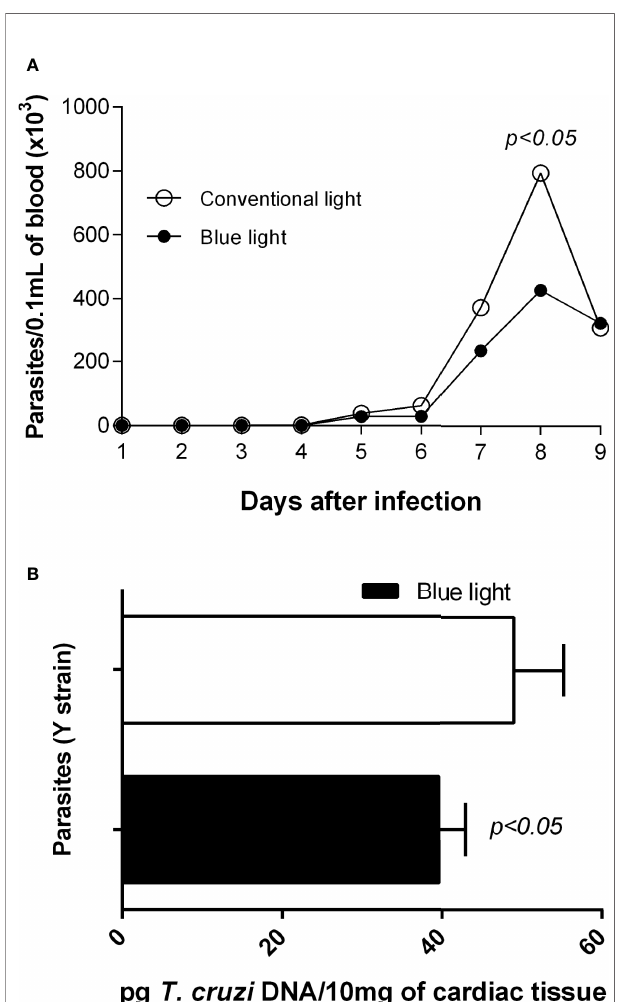
FIGURE 3 | Parasite quanti fi cation and animals ’ survival. (A) - curve of parasitemia; (B) T. cruzi genomic DNA quanti fi cation. C57BL/6 male mice of age 20-22 weeks and mass around 30 g were infected with Y strain of the T. cruzi . Then groups with “ blue light ” were exposed to blue light (with the peak 460 nm and 7 µW/cm2) for 9 days, 12 h per day (from 07:00h to 19:00h). For creating parasitemia curve, blood samples were collected every day and parasites number presented as average. For tissue parasitism, T. cruzi DNA was quanti fi ed in 10mg of cardiac tissue by PCR assay. p<0.05 means differences between groups under conventional and blue light